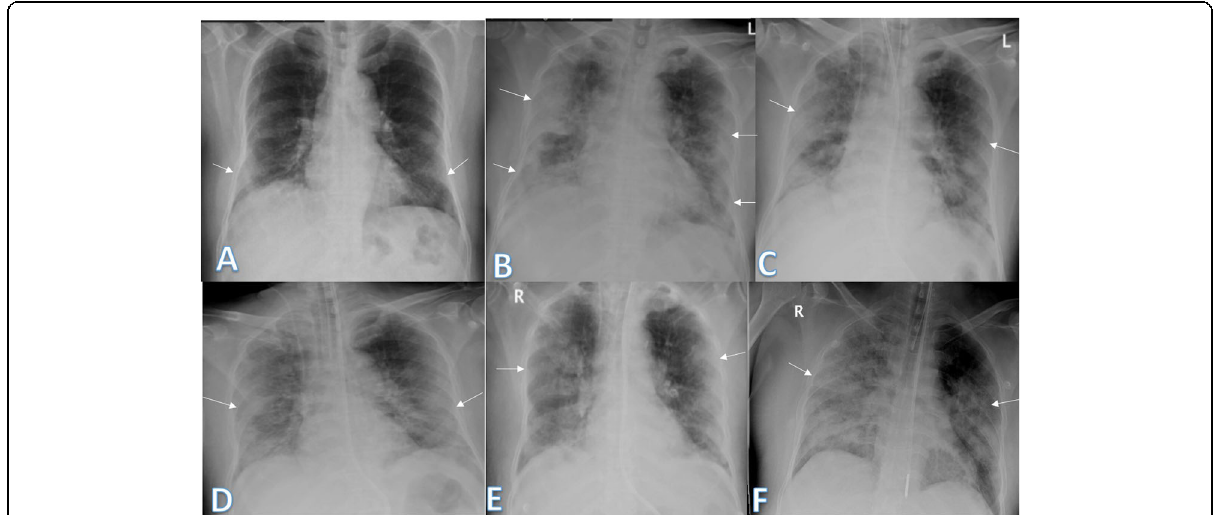
Fig. 21 59-year male with positive COVID-19 virus. Initial X-ray ( a ) showed small peripheral right and left lower zonal air space consolidation opacities (arrows) with TSS as 2. On the 3rd day ( b ), air space consolidation opacities increased extended to the periphery of the upper and middle zones of both lungs (arrows) with TSS as 5 (3 on RT side and 2 on left side). The patient deteriorated and was intubated. On the 5th day ( c ), 6th day ( d ), 9th day ( e ) and 11th day ( f ), there was confluent consolidation (arrows) more on the right lung with severity score 4 on the right side and 3 on the left side, so TSS was 7. The patient died on the 11th